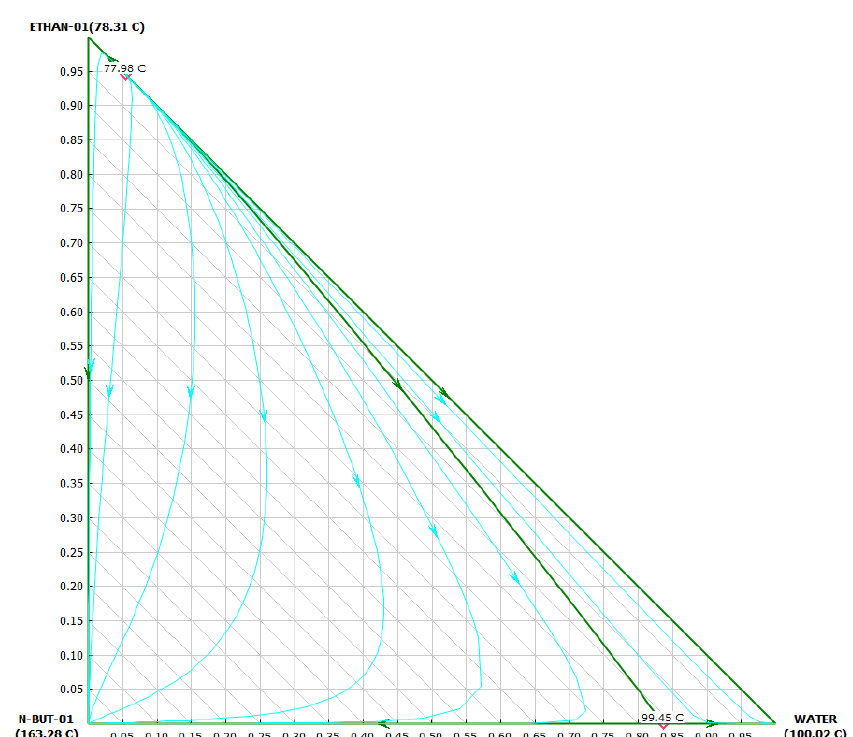
Figure 2. A ternary residue curve map of water, ethanol, and butyric acid with separatrix. The separatrix is drawn in green which starts at the ethanol/water azeotrope and ends at the butyric acid/water azeotrope. Residue curves are drawn in light blue. This diagram is measured in weight fraction.